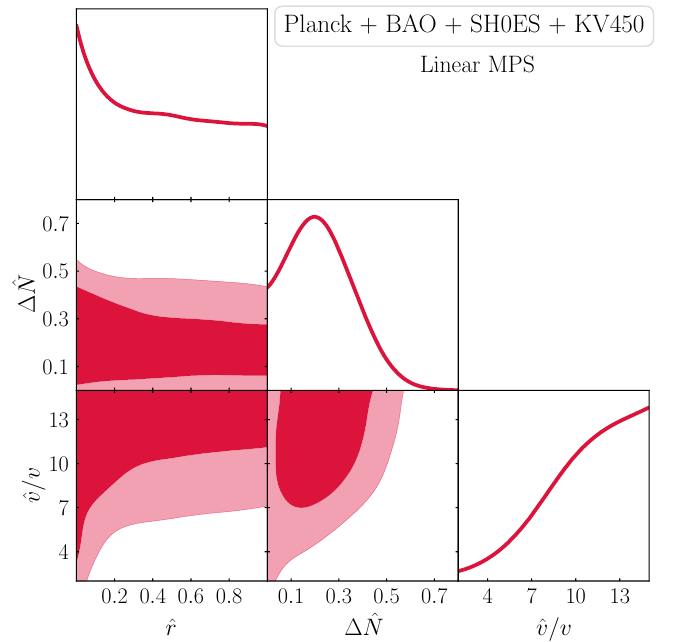
Figure 12. Constraints on all three MTH parameters using the Planck, BAO, KV450, and SH0ES datasets. The linear matter power spectrum has been used in the fit. The corresponding H S 8 plot is shown in figure